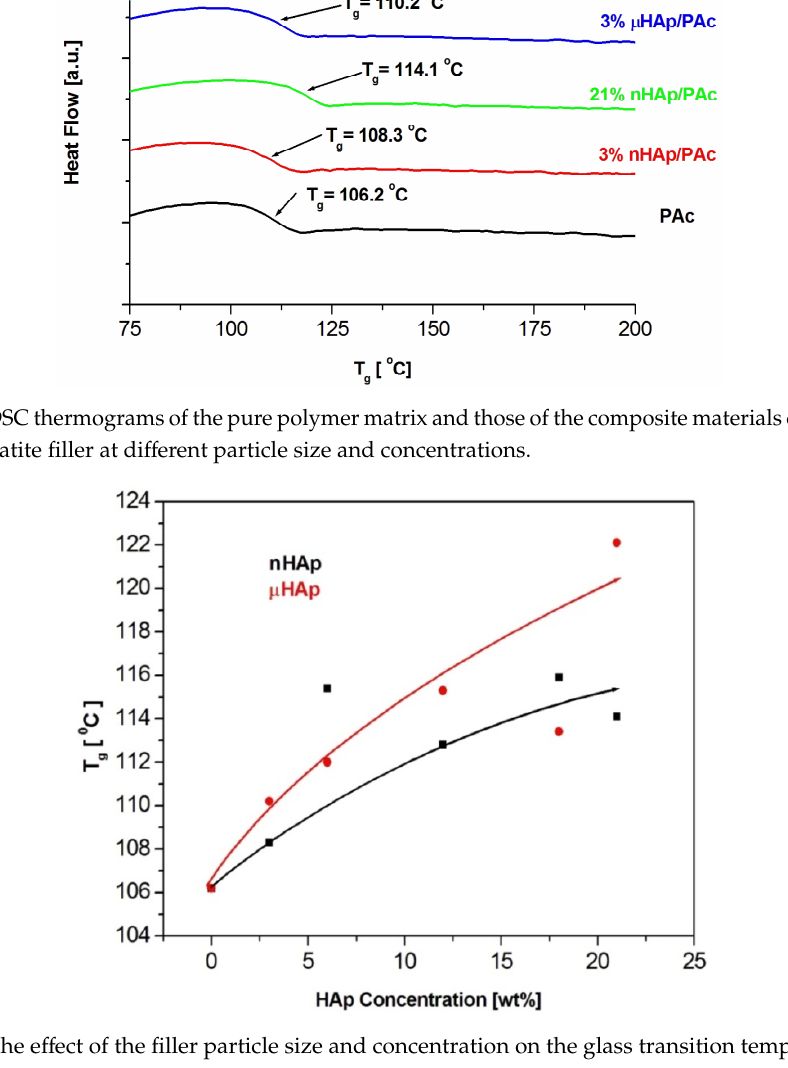
Figure 7. The effect of the filler particle size and concentration on the glass transition temperature of the composite materials.